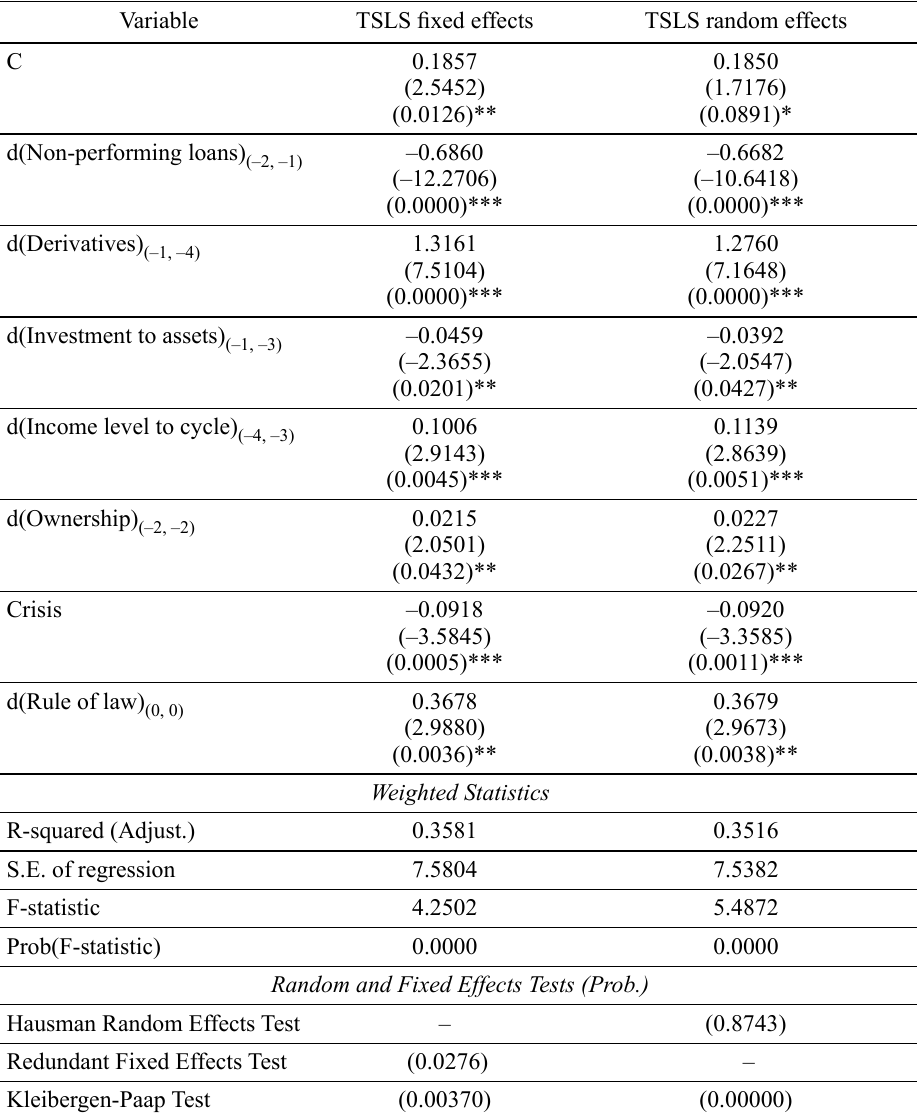
Table 3. Panel regression results for the Baltic States, Romania and Bulgaria Dependent Variable: d(Market share of loans), Cross-sections included: